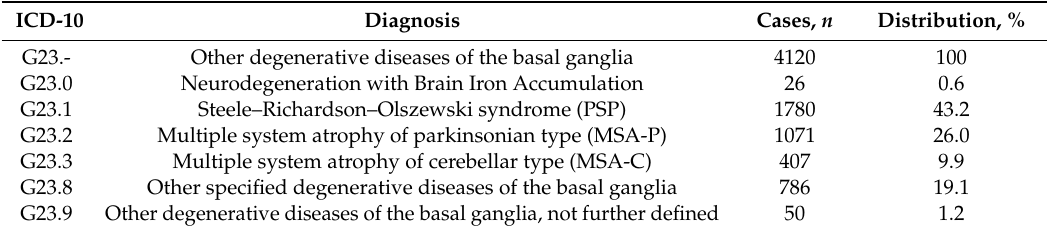
G23.3 Multiple system atrophy of cerebellar type (MSA-C)